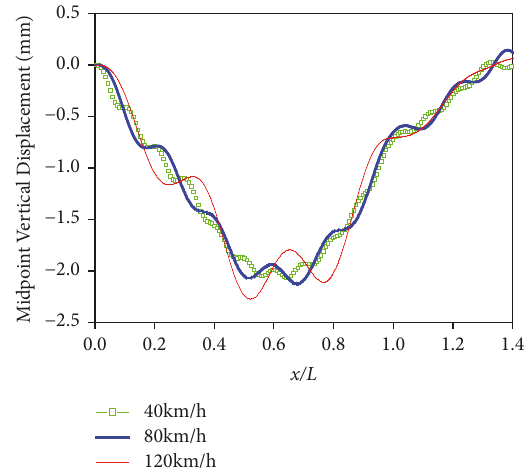
Figure 8: Vertical displacement of midpoint of simply supported beam with different